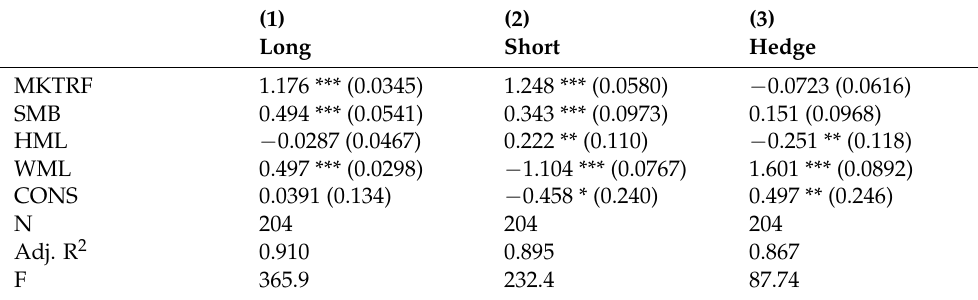
Table 6. High EPU and the four factor asset pricing model.